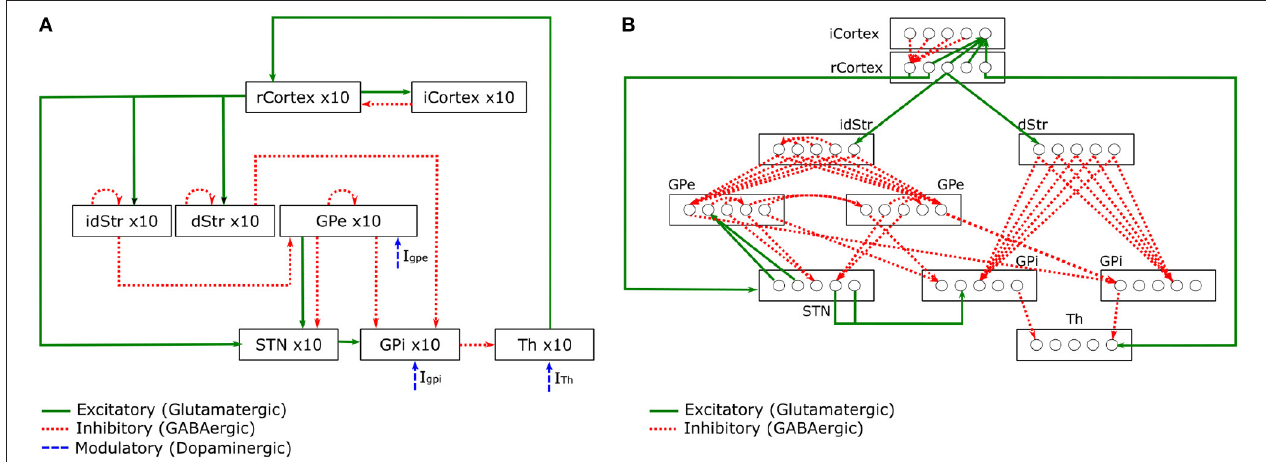
FIGURE 3 | Schematic of the BG-T-C System computational model adapted from Kumaravelu et al. (2016). (A) Shows connections within the network. (B) Details of synaptic connections within the network model. Each rcortical neuron receives excitatory input from one TH neuron and inhibitory input from four randomly selected icortical neurons. Each icortical neuron receives excitatory input from four randomly selected rcortical neurons. Each dStr neuron receives excitatory input from one rcortical neuron and inhibitory axonal collaterals from three randomly selected dStr neurons. Each idStr neuron receives excitatory input from one rcortical neuron and inhibitory axonal collaterals from four randomly selected idStr neurons. Each STN neuron receives inhibitory input from two GPe neurons and excitatory input from two rcortical neurons. Each GPe neuron receives inhibitory axonal collaterals from any two other GPe neurons and inhibitory input from all idStr neurons. Each GPi neuron receives inhibitory input from two GPe neurons and inhibitory input from all dStr neurons. Some GPe/GPi neurons receive excitatory input from two STN neurons, while others do not. Each TH neuron receives inhibitory input from one GPi